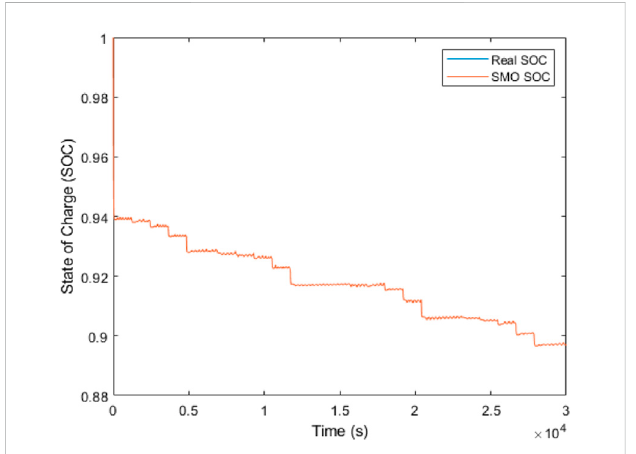
FIGURE 9 Response of the SMO under INR 18650.